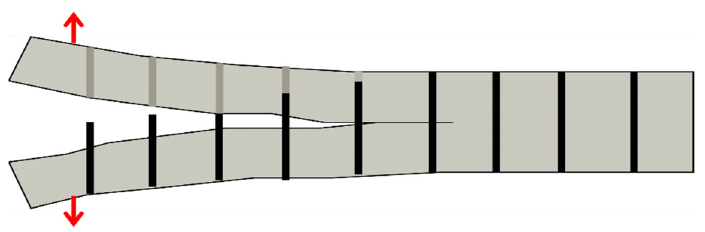
Figure 23. Schematic of z-pinned specimen with a steady state crack growth. J. Hoffmann and G. Scharr [111] analysed the effect of various geometric shape pins on composites’ fatigue resistance with two different ply-stacking sequences. According to the Paris curves, the rectangular z-pins were more efficient than the circular z-pins in growing delamination resistance of quasi-isotropic composites. In unidirectional compos- ites, when the cross-section of the pins was changed, it slightly affected the mode I fatigue delamination resistance of the z-pins